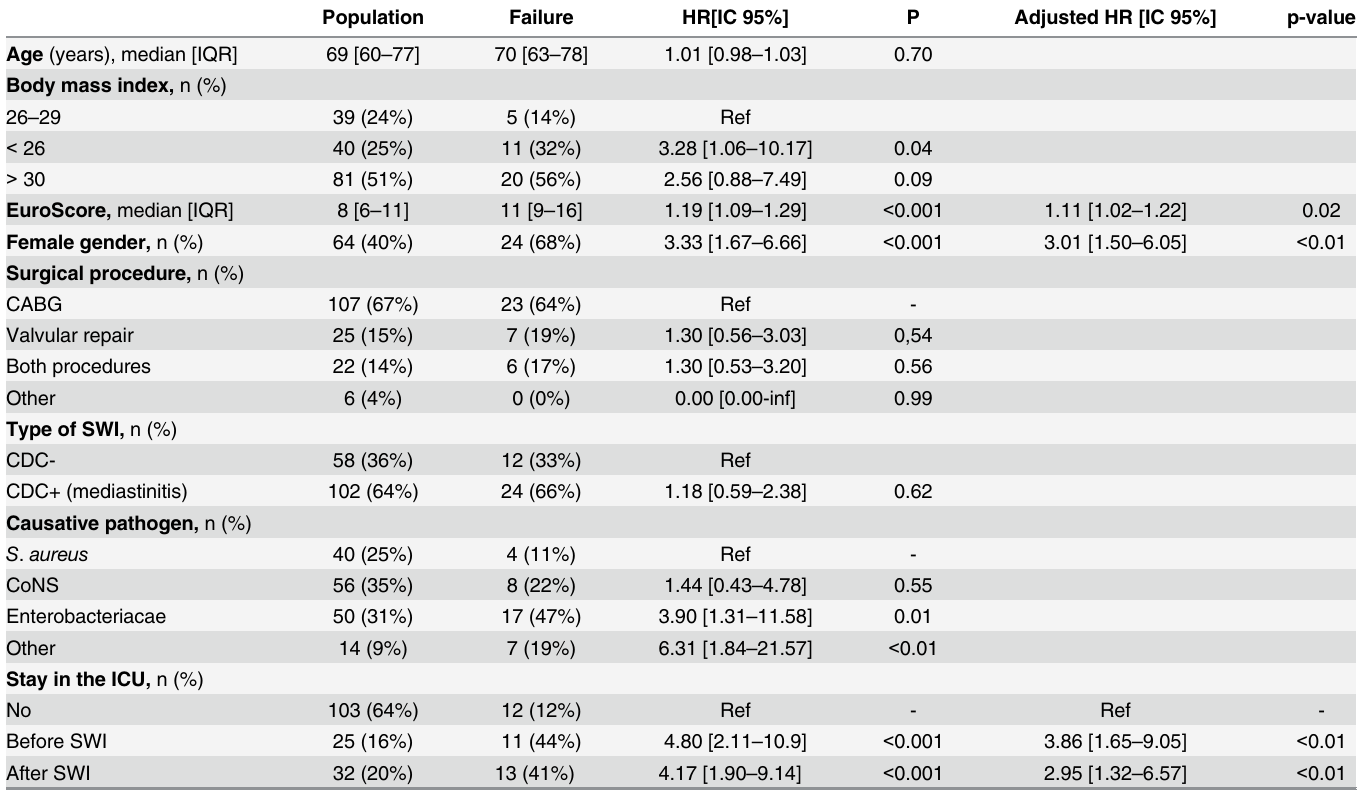
Table 4. Variables Associated with Failure (n = 36), Cox Proportional Hazard